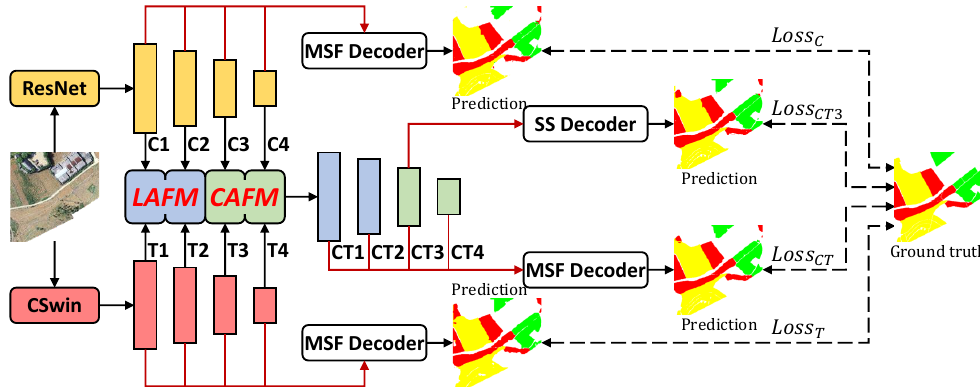
Figure 5. The overall framework of the